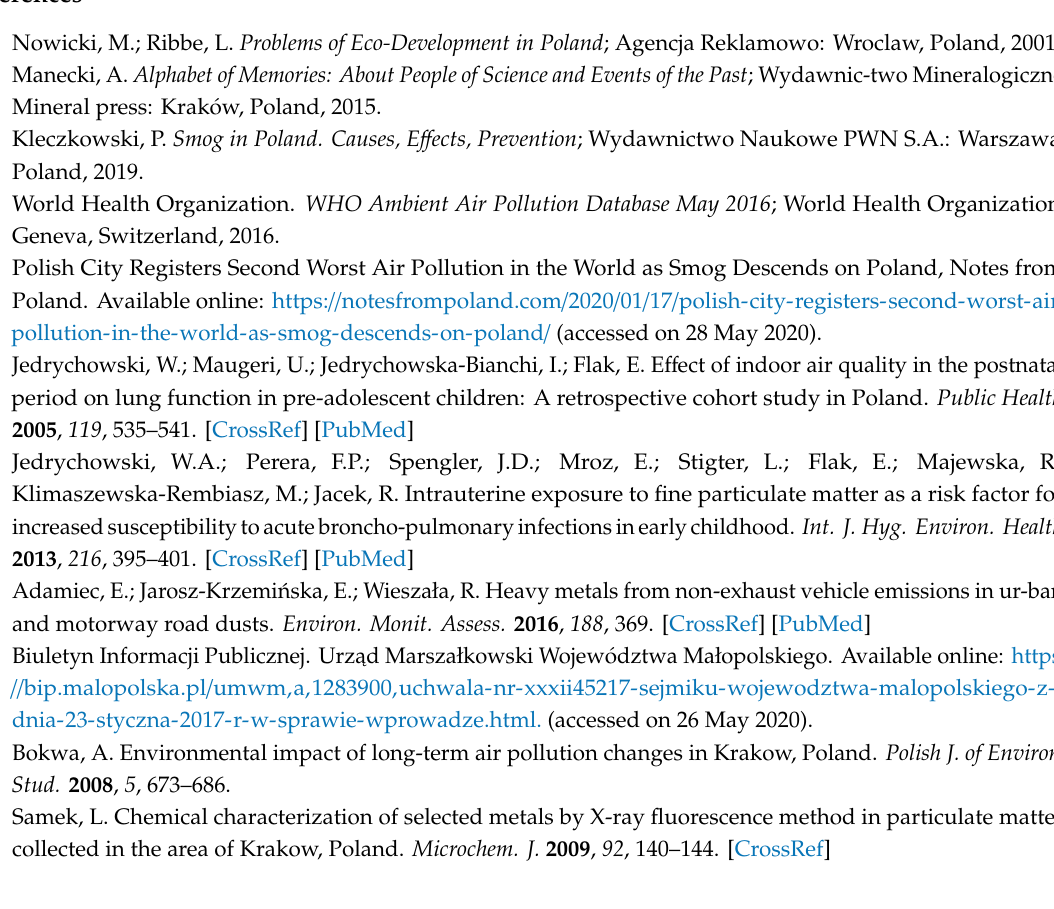
Figure S1. A demonstrative wind rose in Krak ó w Poland: share of wind directions in % (a), and wind speed distribution in m / s (b), divided into cool and warm half-years. Figure S2. Location of air-flow corridors and Regional Environmental Protection Inspectorate air monitoring stations in Krak ó w. Table S1. Description of the air monitoring stations operated by the Regional Environmental Protection Inspectorate (REPI) in Krak ó w. Table S2. Ranges of the 1 h concentrations in the Polish air quality index (AQI) for selected pollutants. Table S3. The Polish AQI index and the corresponding health recommendations for residents. Table S4. Description of the enrichment indices used in the study. Table S5. Exposure parameters used for the risk assessment calculations under resident scenario in the study. Table S6. Toxicological parameters used for the risk assessment calculations under resident scenario in the study. Table S7. Changes in annual air pollutant contents in Krak ó w in 2005–2020, with permissible levels. Table S8. Changes in monthly air pollutant contents in 2018 in Krak ó w; average values of all the monitoring stations. Table S9. Changes in daily air pollutant contents in a selected winter month, average values for Krak ó w, March 2018, with recommended concentrations. Table S10. Changes in daily air pollutant contents in a selected summer month, average values for Krak ó w, July 2018, with recommended concentrations. Table S11. Daily and hourly SO 2 content changes, with the hourly Polish AQI index, average values for Krak ó w, March 2018. Table S12. Daily and hourly CO content changes, with the hourly Polish AQI index, average values for Krak ó w, March 2018. Table S13. Changes in monthly air-pollutant contents in the first half of 2020 in Krak ó w, average values from all the monitoring stations. Table S14. Estimated daily intake values for the resident of Krak ó w, in reference to exposure